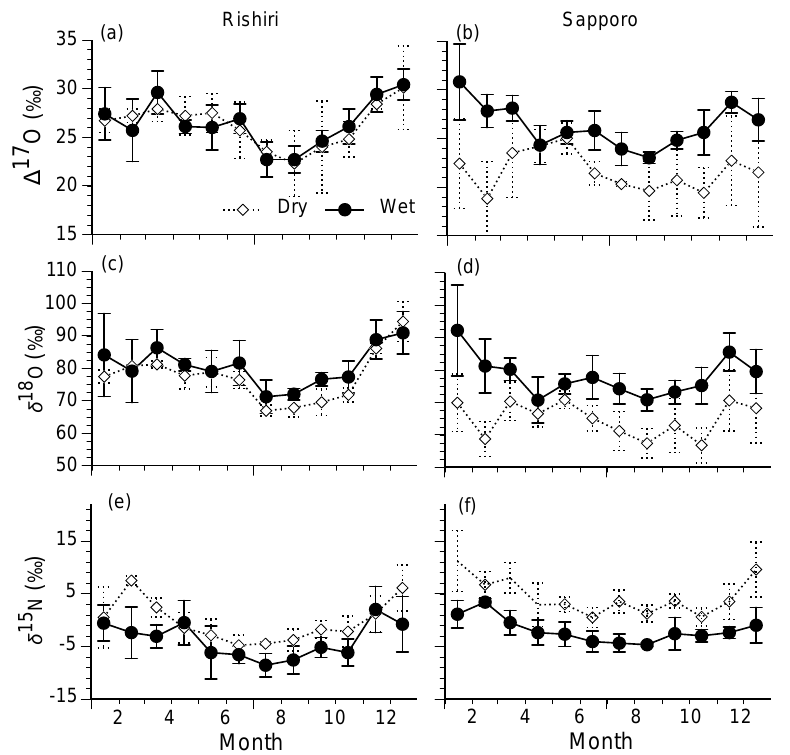
Figure 3. Time series of monthly weighted-average (a, b) (cid:49) 17 O values of nitrate in dry and wet deposition, (c, d) δ 18 O values of nitrate in dry and wet deposition, and (e, f) δ 15 N values of nitrate in dry and wet deposition. Data from Rishiri (rural) are in left column and data from Sapporo (urban) are in right column. Error bars on isotopic values of nitrate in dry deposition represent one standard deviation of isotopic values of nitrate in coarse and fine particles and in gaseous form, whereas errors bars on isotopic values of nitrate in wet deposition represent one standard deviation of all isotopic values of nitrate in wet deposition made during the sampling